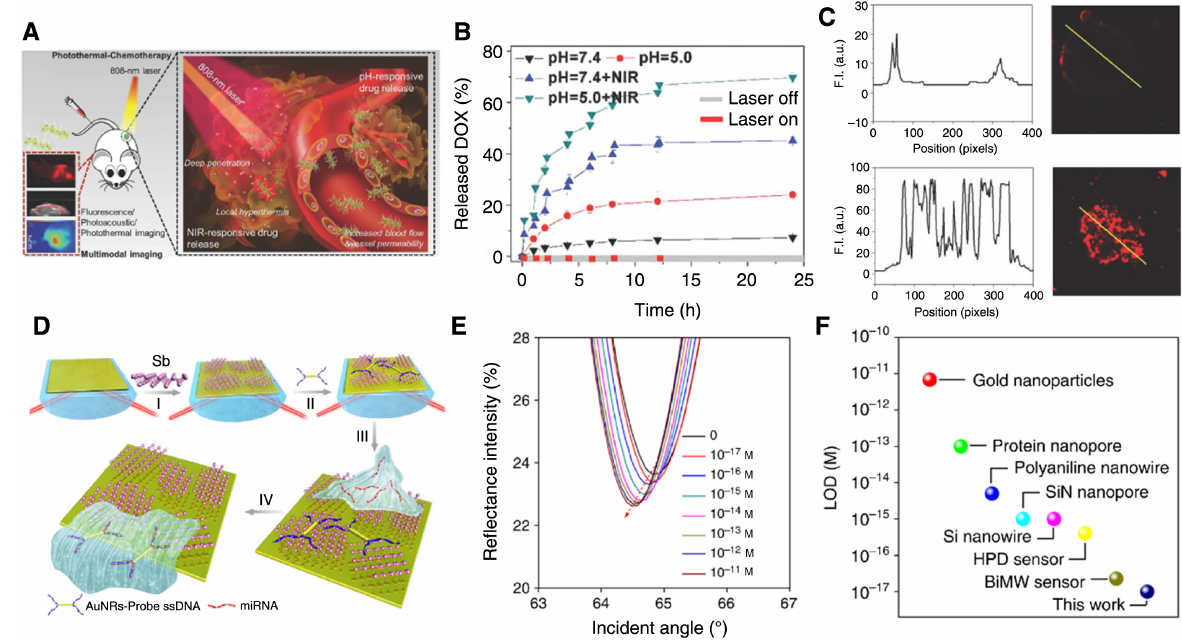
Figure 9: The performance of antimonene- and bismuthene-based microfiber, converer, modulator, and solar cell. (A) The systemic illustration of the PEG-antimonene/DOX drug-delivery platform as photonic nanomedicines for multimodal-imaging-guided cancer theranostics. (B) Release profiles of DOX at different pH conditions with or without NIR laser irradiation (808 nm, 0.8 W cm −2 ). (C) The comparison of fluorescence intensity and images of tumor spheroids with and without laser irradiation. Reproduced with permission [151]. Copyright 2018, John Wiley and Sons. (D) The fabrication and detection mechanism of an antimonene-based SPR sensor for miRNA sensing. (E) The SPR spectra of antimonene sensor for detecting miRNA-21 with concentrations varying from 10 −17 to 10 −11 m. The shift of SPR angle is indicated by the red arrow. (F) The comparison of the low LOD of the antimonene-based miRNA SPR sensor with other state-of-the-art sensors. Reproduced with permission [104]. Copyright 2019, Springer